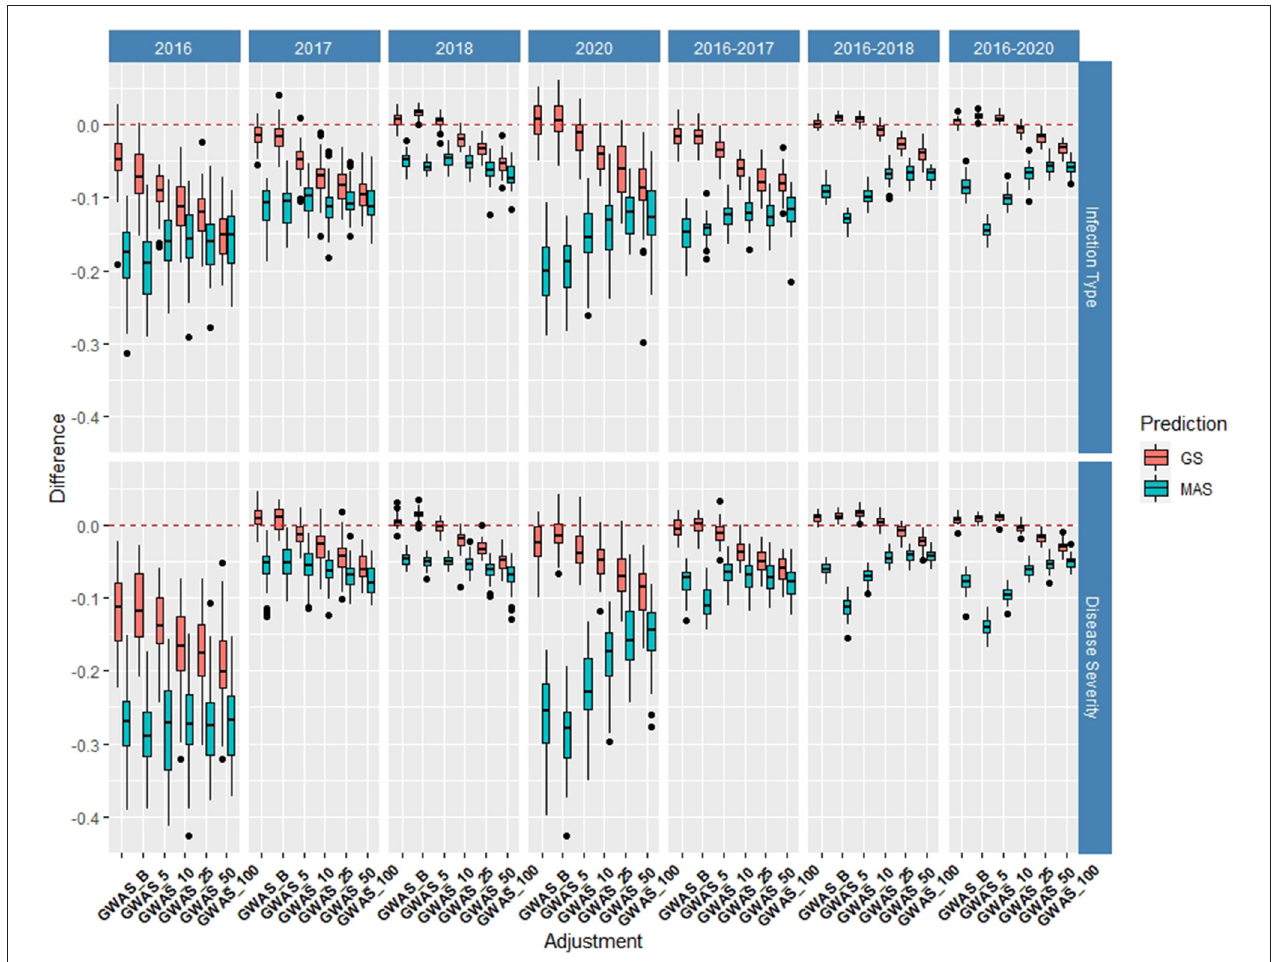
FIGURE 6 | Difference in prediction accuracy from the base rrBLUP model for de novo genome-wide association study (GWAS) markers in GS and MAS using cross-validations in the BLs phenotyped from 2016 to 2020. Adjustments: GWAS_B, genome-wide association study assisted GS (GWAS-GS) with Bonferonni significant markers; GWAS_5, GWAS-GS with the top five significant markers; GWAS_10, GWAS-GS with the top 10 significant markers; GWAS_25, GWAS-GS with the top 25 significant markers; GWAS_50, GWAS-GS with the top 50 significant markers; GWAS_100, GWAS-GS with the top 100 significant